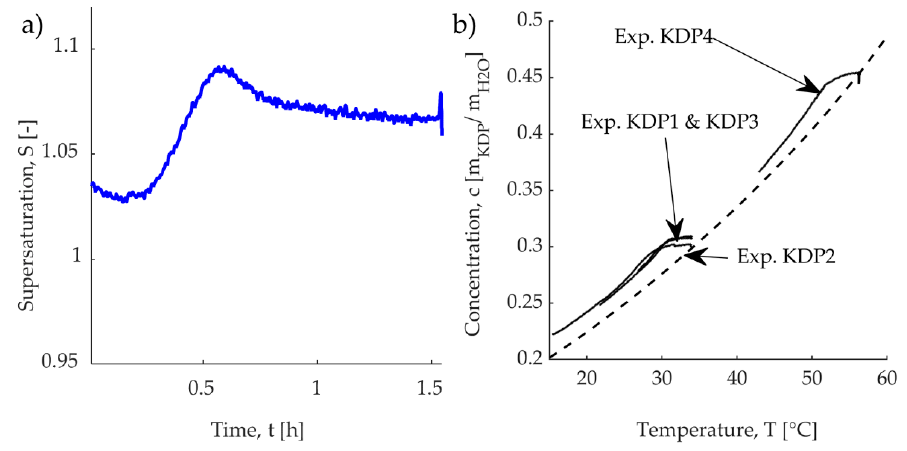
Figure 5. ( a ) Supersaturation profile calculated for Exp. 3—KH 2 PO 4 with the FTIR data, ( b ) Liquid phase concentration for Exp. 1–4 KH 2 PO 4 , measured with the FTIR depicted in a part of the binary phase diagram of KH 2 PO 4 / H 2 O. The dashed line is the saturation curve according to Equation (1). The experiment was carried out until the concentration was too high to identify single